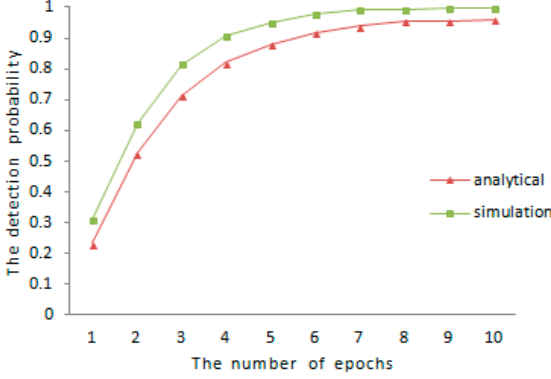
Figure 2. Comparison of detection probability ( R = 100, N =